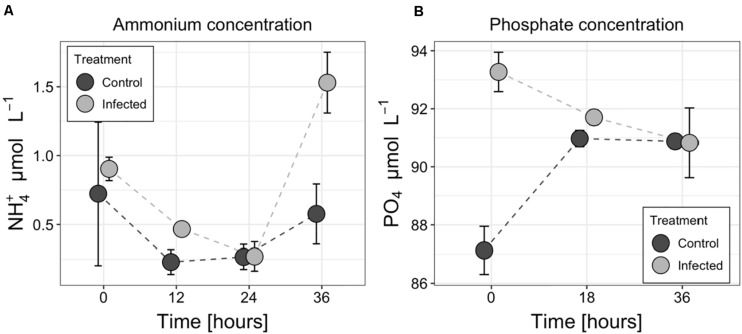
Changes in ammonium (A) and phosphate (B) concentrations in the medium of the control and infected cultures of the Aphanizomenon flos-aquae strain 2012/KM1/D3. Symbols indicate the mean values, and the error bar shows the standard deviation of three technical replicates.